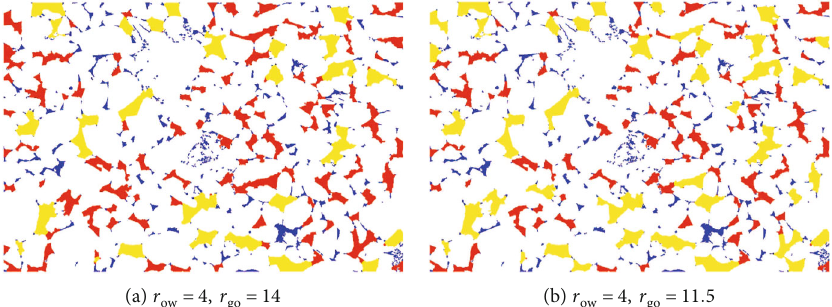
Figure 11: Three-phase fl uid con fi gurations for two gas invasion processes originating from di ff erent initial oil and water saturations in a weakly water-wet nonspreading system. The gas-oil and oil-water capillary pressure radii are given in pixel lengths. Yellow region: gas; red region: oil; blue region: water.